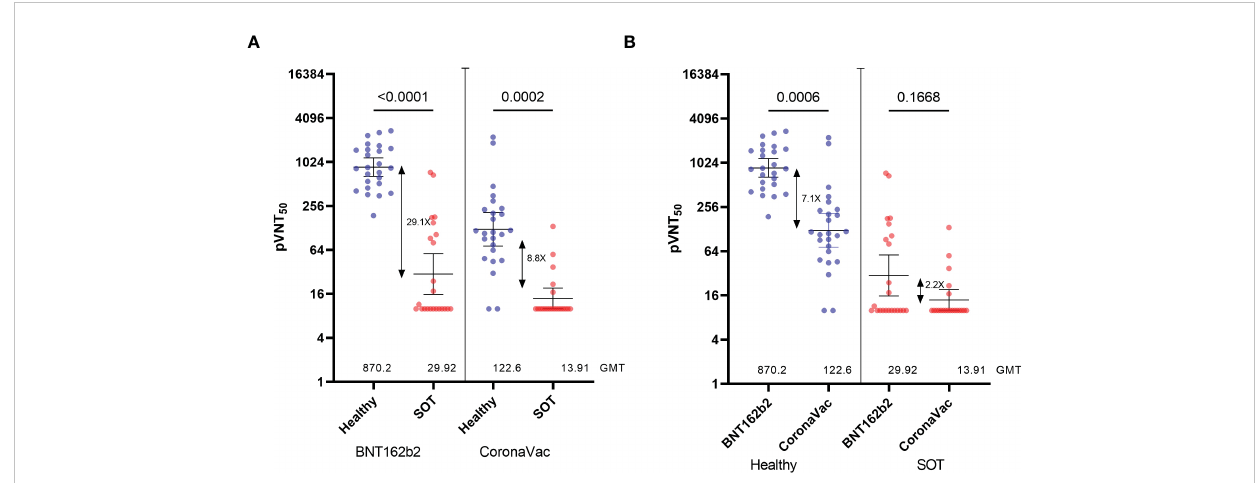
FIGURE 2 Neutralization titers of serum from Healthy and SOTRs 90 days after the two-dose BNT162b2 and CoronaVac vaccines. 50% pseudovirus neutralization titers (pVNT 50 ) of 50 healthy recipients (blue) of the CoronaVac (n=25) and BNT162b2 (n=25) vaccines and 44 SOTRs (red) of the CoronaVac (n=21) and BNT162b2 (n=23) against pseudotypes (A, B) ancestral reference strain (D614G). Statistical signi fi cance of the difference between the neutralization was calculated by the two-tailed Kruskal – Wallis test after adjustment for the false discovery rate. Two-tailed P values are reported. Geometric mean titers (GMTs) and 95% CIs are indicated. Factor changes are shown in brackets as the difference of the geometric mean titer in the pVNT 50 . Graphs Y axes are presented in logarithmic (log 2 )